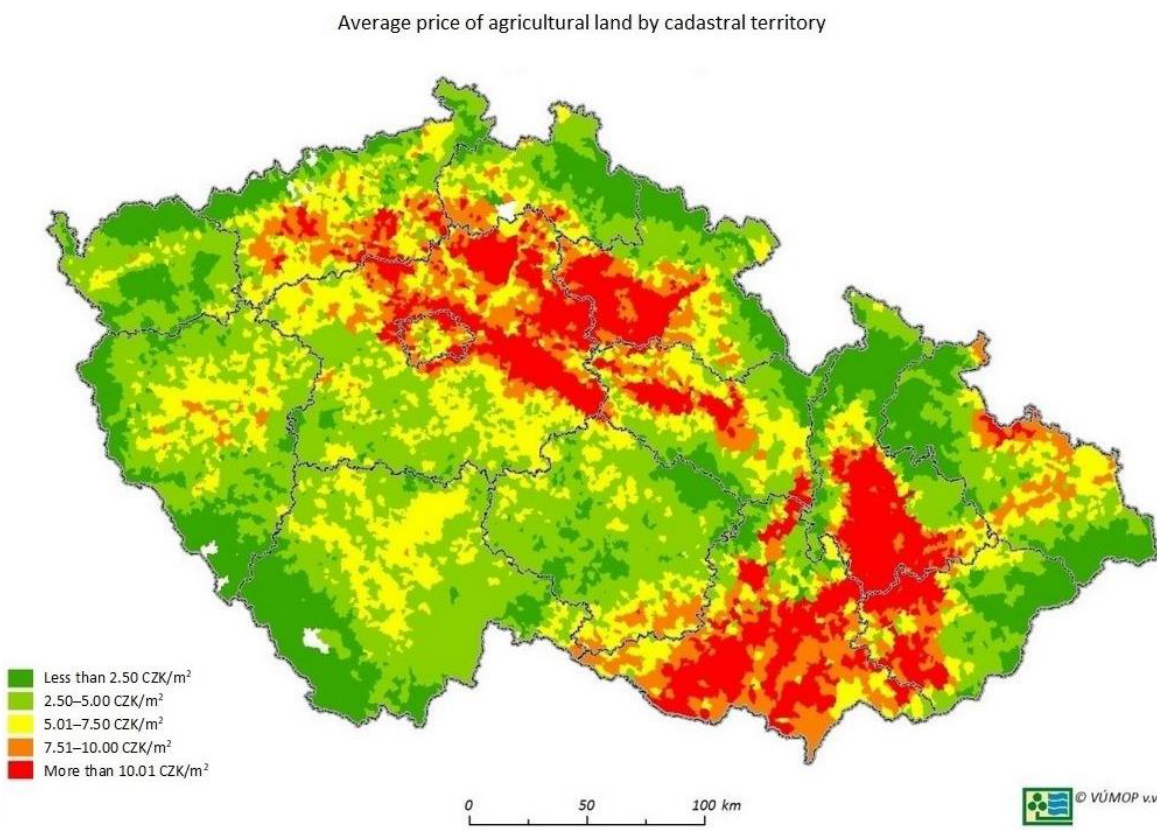
Figure 3. Average official price of agricultural land by cadastral territory.